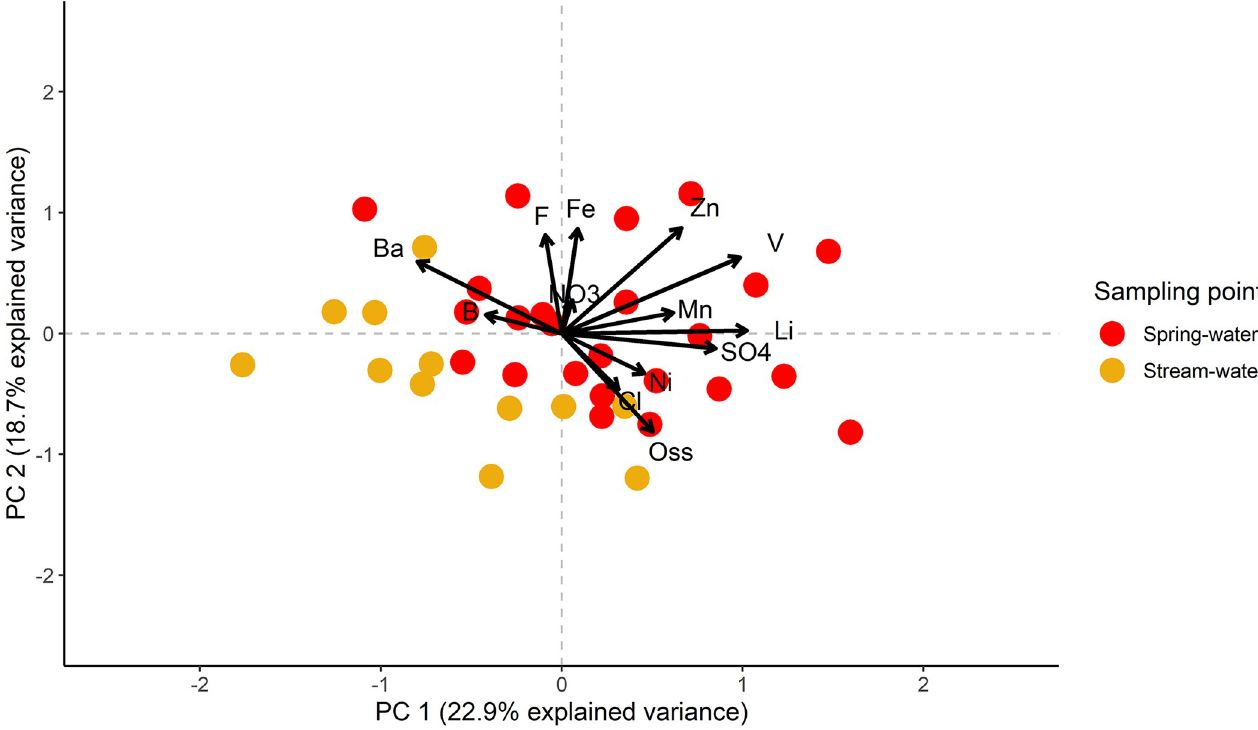
Fig 10. Plot of PCA1. Acronyms are used for permanganate oxidation (Oss), NO 3- (NO3), Cl - (Cl), F - (F), and SO 42- (SO4). https://doi.org/10.1371/journal.pone.0268252.g010 and Albidona B/C (AAP) with F(1) = 4.936, adjusted p = 0.040. On the contrary, hydrochemi- cal differences between AAPD and AAP were not significant, with F(1) = 0.739, adjusted p = 0.576. Comparing the few mineralogical aspects of the geological formations available for